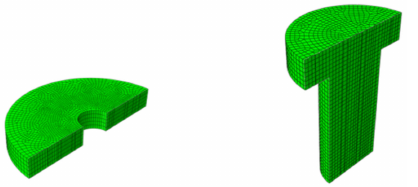
Figure 2. Finite element model of interference